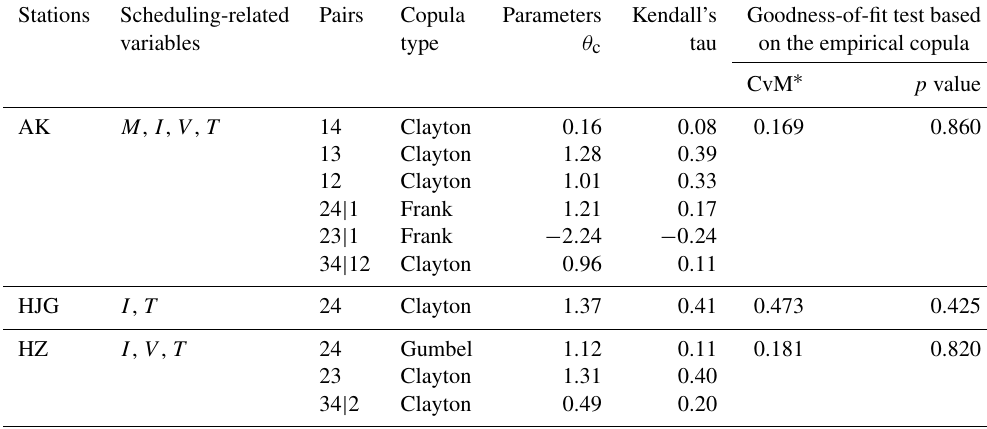
Table 6. Results of the copula models for scheduling-related rainfall variables.